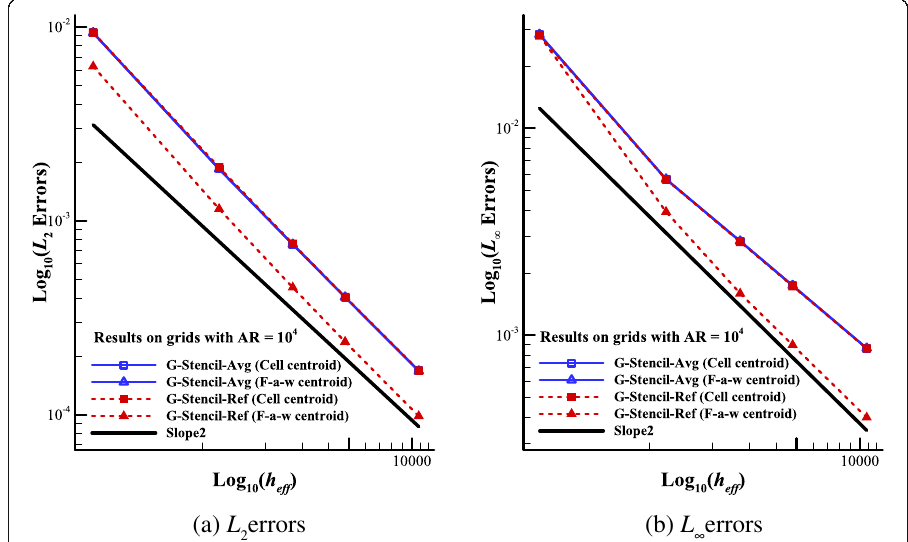
Fig. 17 ( a ) L 2 and ( b ) L ∞ errors. Cell-averaged and point-valued discretization errors of G-Stencil with the geometric centroid and face-area-weighted centroid on grids with AR = 10